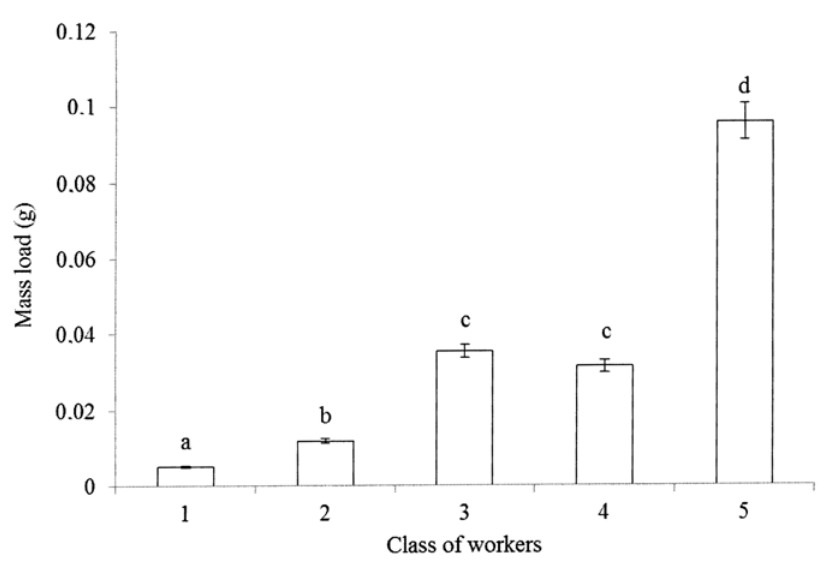
Fig. 2. Mass (g) (mean ± SE) of load transported by different classes of workers of Atta robusta in restinga ecosystem from Grussaí/Iquipari complex. Class 1 (head capsule 1 to 2 mm), class 2 (head capsule 2.1 to 3 mm), class 3 (head capsule 3.1 to 4 mm), class 4 (head capsule 4.1 to 5 mm) and class 5 (head capsule ( ≥ 5.1 mm5 to 6 mm). Different letters indicate significant difference by Tukey test, p <